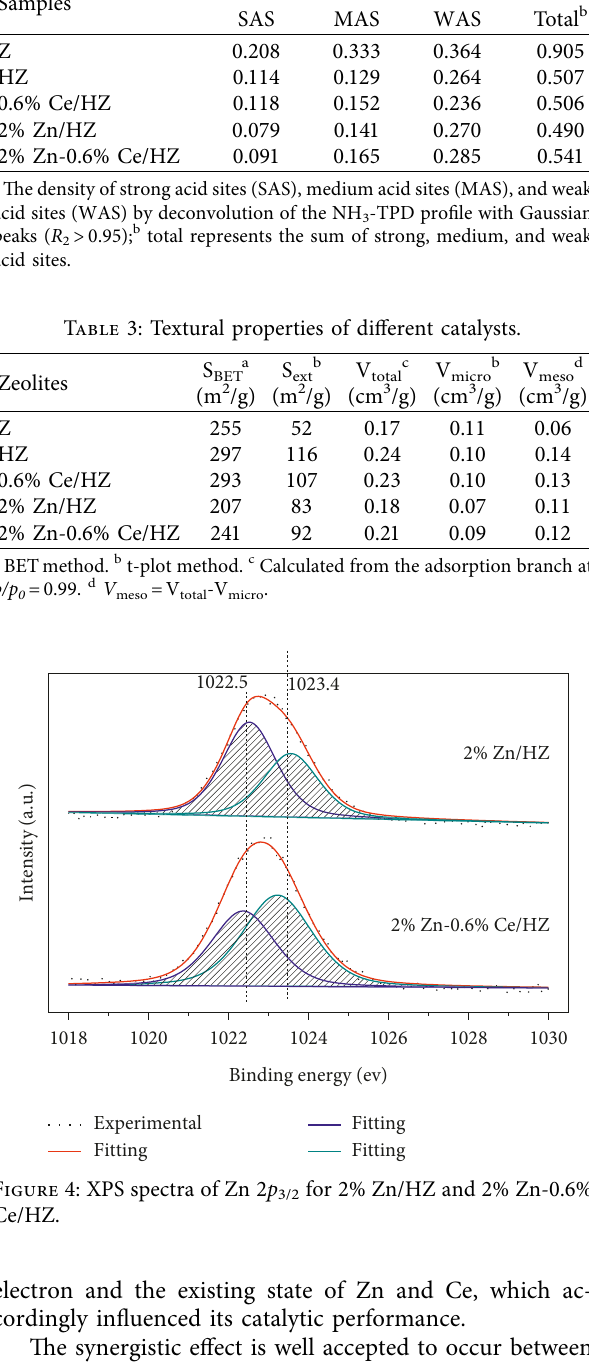
3/2 for 2% Zn/HZ and 2% Zn-0.6%